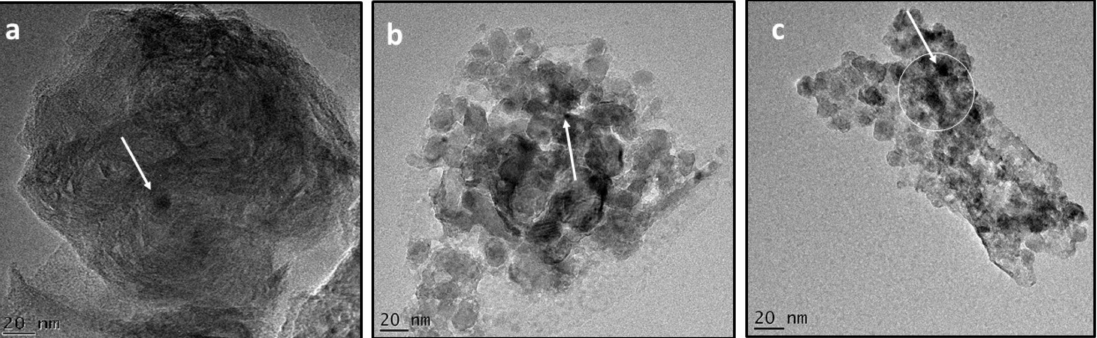
Figure 7. TEM images of Ni/MgAl 2 O 4 sulfided with (NH 4 ) 2 SO 4 (S1) at ( a ) 200 ◦ C, ( b ) 400 ◦ C, and ( c ) 550 ◦ C. Nickel-sulfided species indicated by white arrows.